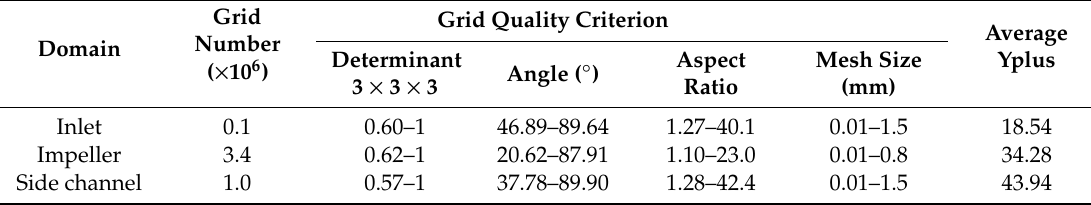
Figure 6. Velocity streamlines in the middle plane of the impeller under different grid numbers. ( a ) 3.7 million ( b ) 4.0 million ( c ) 4.5 million ( d ) 4.8 million ( e ) 5.0 million. Table 1. Structured grid data.